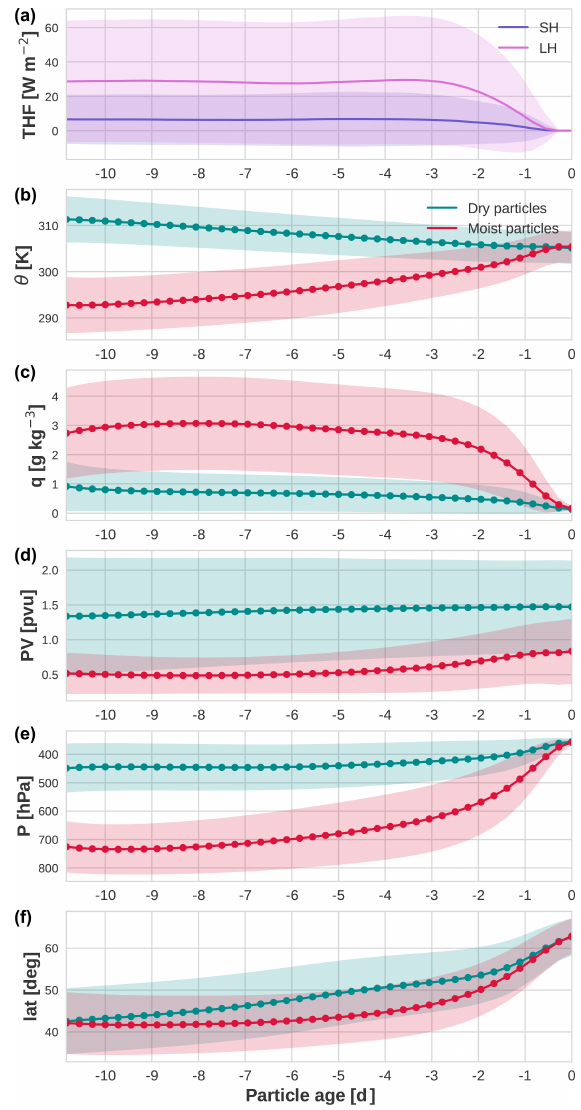
Figure 5. Time evolution of the properties of dry and moist par- ticles along their respective trajectories. (a) Mean sensible (blue) and latent heat fluxes (magenta) supplied to moist particles from the ocean when the particles reside within the marine PBL at specific particle age. (b–f) Mean potential temperature (b) , mean specific humidity (c) , mean potential vorticity (d) , mean pressure (e) , and mean latitude (f) of dry (cyan lines) and moist particles (red lines) along their respective trajectories. The envelopes around each line indicate ± 0 . 5 standard deviations. The particle age on the x axis de- notes the days before the particles arrive at the blocking system (i.e., day 0 means the arrival time at the blocks). The closed (open) cir- cles indicate where a given property distribution between moist and dry particles is significantly different at the 99% (95%) confidence level. The maximum standard errors are 0.05Wm − 2 for turbulent fluxes, 0.009K for potential temperature, 0.002gkg − 1 for specific humidity, 0.001PVU for PV, 0.2hPa for pressure, and 0.01 ◦ for lat-